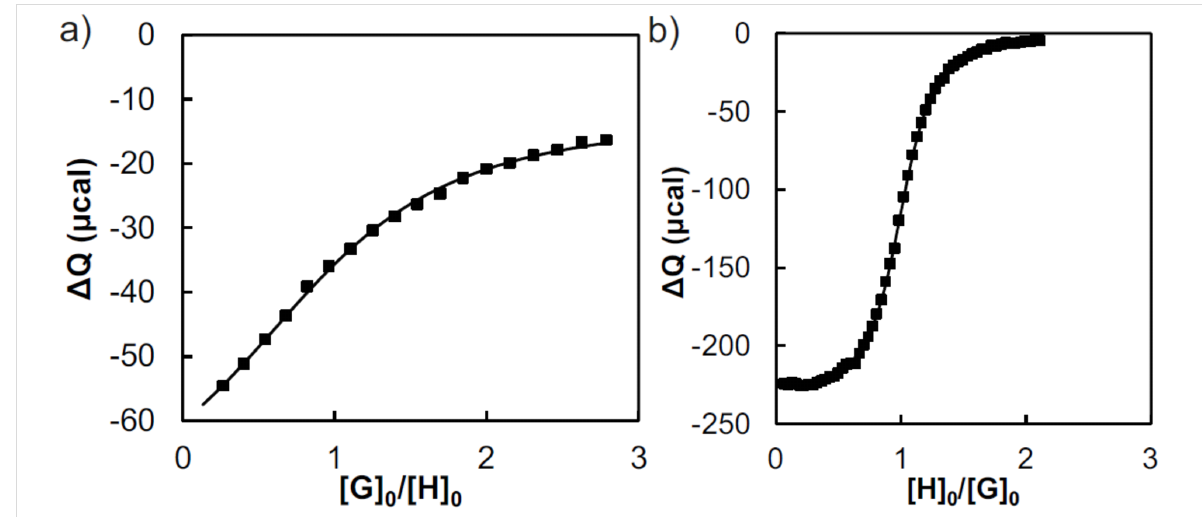
Figure 1: Microcalorimetric titrations of a) CD-PEI (CD concentration of 0.088 mM, cell) with Ad-TEG (1.1 mM, burette) and b) Ad-TEG (1.1 mM, cell) with CD (10 mM; burette). H = host (CD from CD-PEI or native CD) and G = guest (Ad from Ad-TEG). Experimental binding curve (markers) and best fit to a 1:1 model (line).